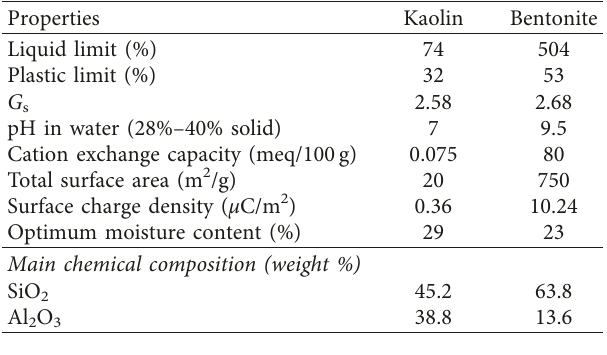
Table 2: Properties of testing soils [26, 27].